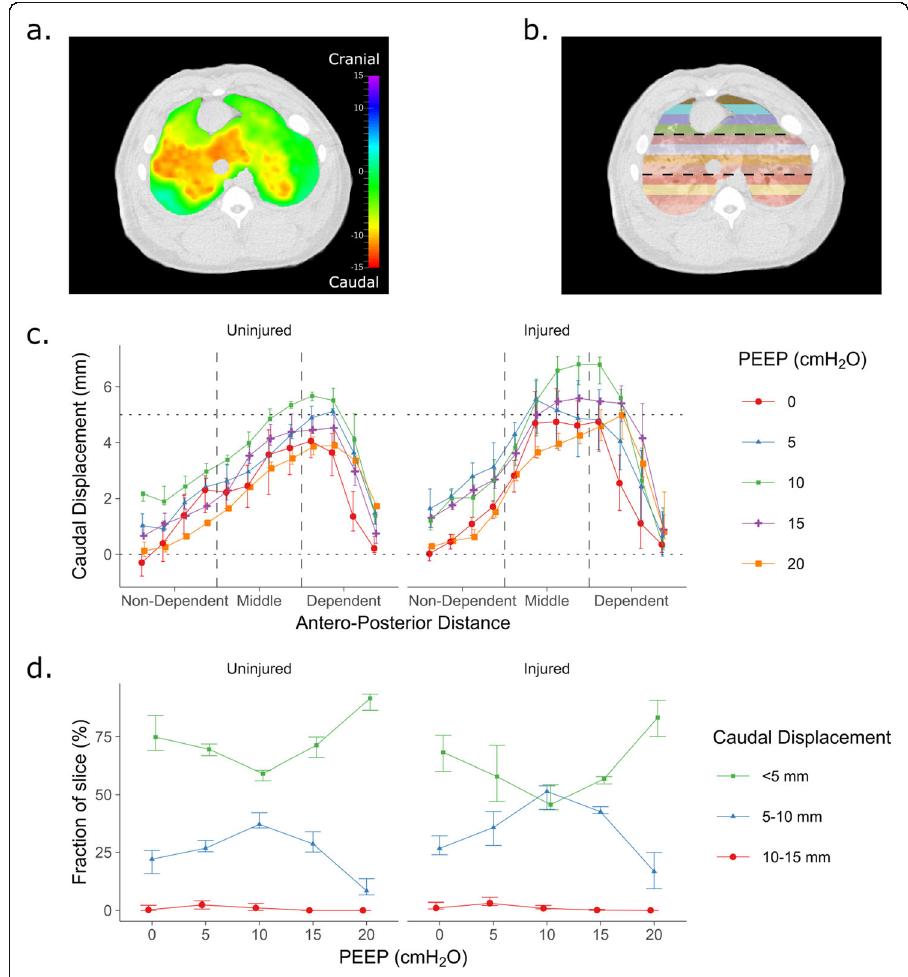
Fig. 5 Results of the morphological analysis of single-energy volume CT scans between expiration and inspiration. a Example of the level of the whole-lung CT equivalent to that studied for the dynamic CT series, taken from an injured animal at PEEP 10 cmH 2 O. Overlaid is the cranio-caudal displacement of individual voxels in the slice demonstrating the majority of the displacement occurring in the middle third of the lung along the gravitational vector. b Example segmentation into 12 regions of equal height along the gravitational vector. c Quantification of the caudal displacement of the slice between expiration and inspiration in each of the 12 regions at different PEEP levels. Division into non-dependent, middle and dependent regions as per thick horizontal dashed lines in b . d The fraction of the slice that moves less than one slice (< 5 mm), between one and two slices (5 – 10 mm) and more than 2 slices (10 – 15 mm) in inspiration when grouped by PEEP. Points in c and d represent median and IQR of 4 injured and